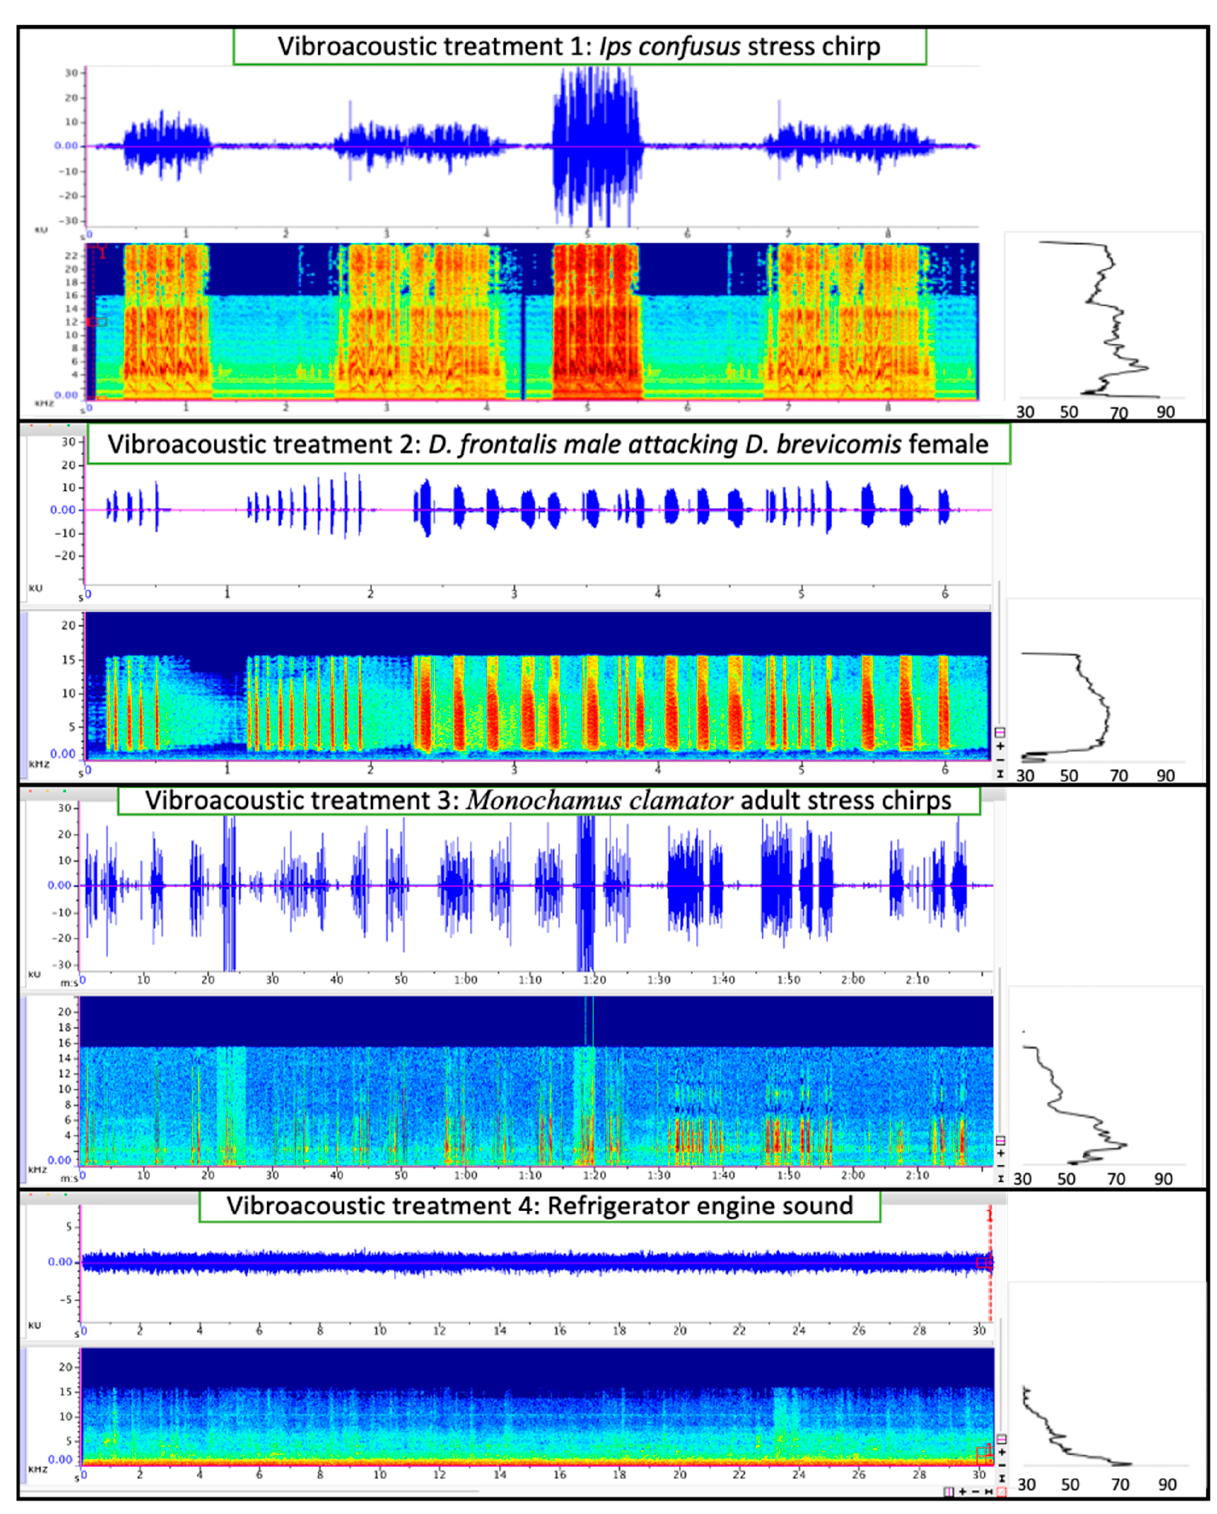
Figure 5. Waveform (top panel, amplitude over time in seconds, spectrograph (bottom panel, kHz over time in seconds) and mean spectrum (right panel, kHz over dB re 20 μ Pa) of vibroacoustic treatments (1 through 4) played into logs to test Ips confusus behavior. The x-axis is in seconds.